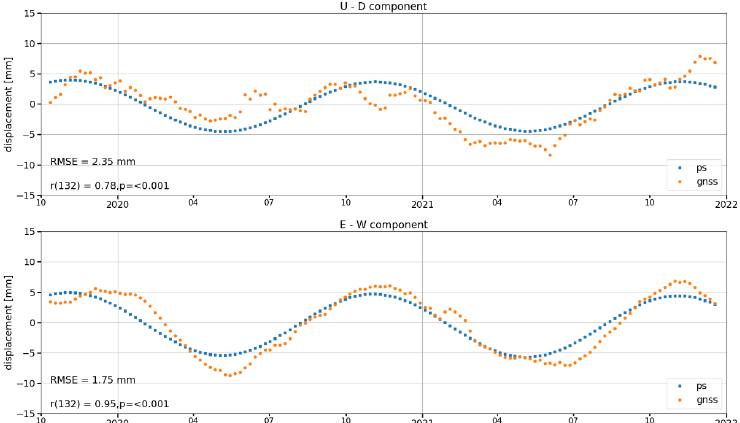
Figure 15. Comparison of GNSS and PSInSAR recalculated in the U–D and E–W directions for patch 597 in Figure 5.